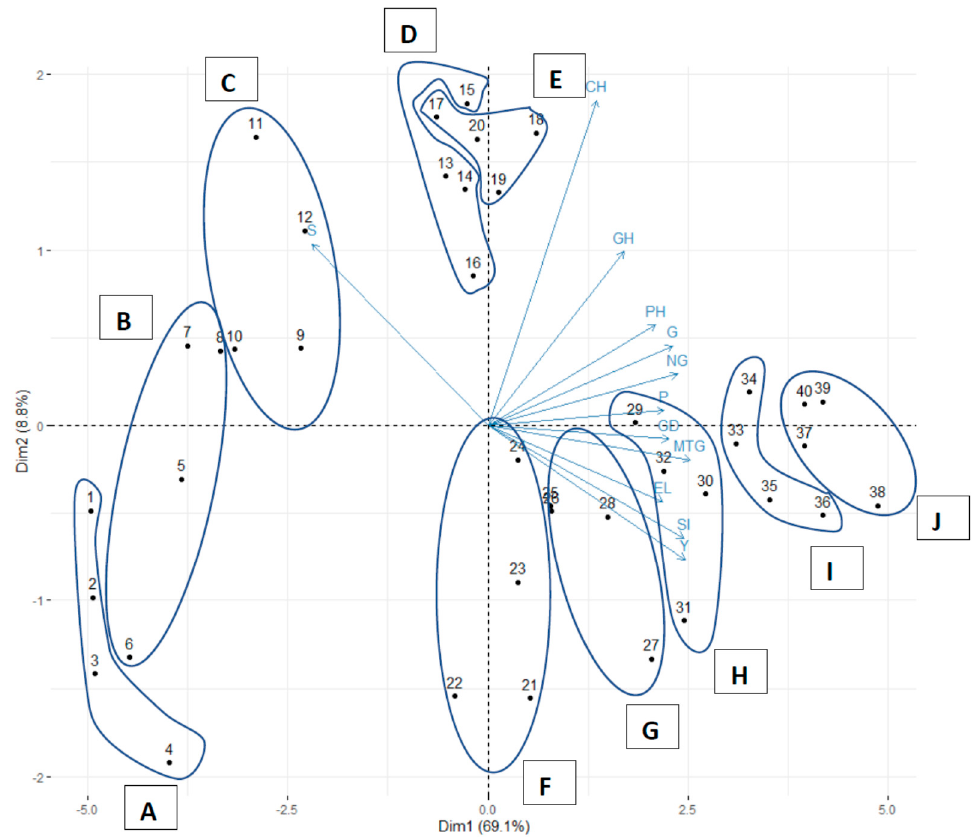
Figure 1. PCA biplot showing the interaction between individuals (1, 2, ... , 40) and selected traits. A: Control-NN-2013; B: ASA3-T1/T2-2013; C: ASA5-T1/T2-2013; D: ASA3-T3/T4-2013; E: ASA5-T3/T4-2013; F: Control-NN-2014; G: ASA3-T1/T2-2014; H: ASA5-T1/T2-2014; I: ASA3-T3/T4-2014; J: ASA5-T3/T4-2014. PH-plant height; EL-ear length; CH-chlorophyll; NG-number of grains per ear; MTG-mass of thousand grains; Y-yield; P-proteins in grain; G-gluten in grain; S-starch in grain; SI-sedimentation index; GH-grain hardness index; GD-grain density.